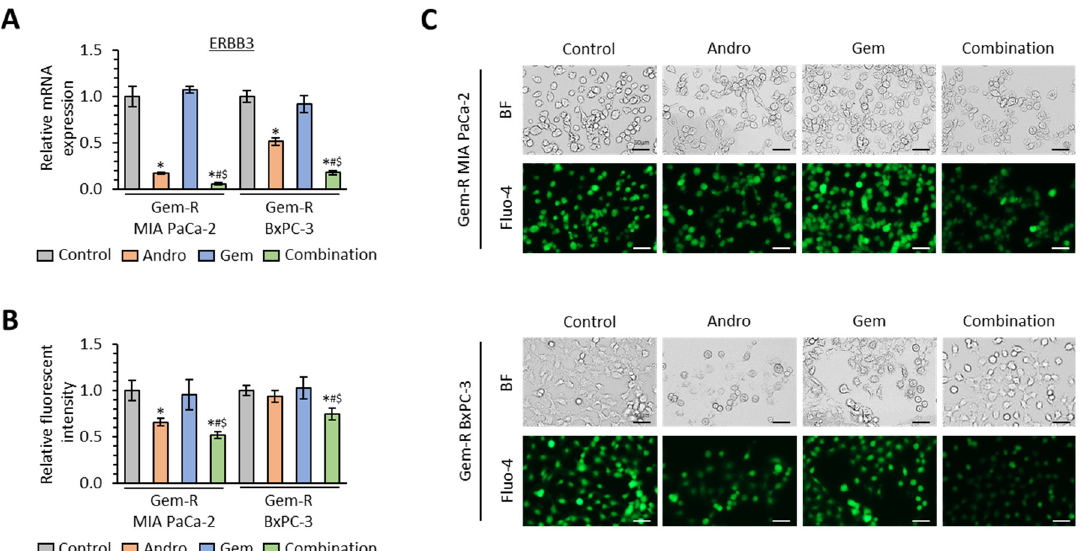
Figure 5. The combination of Andrographis and Gemcitabine down-regulates ERBB3 expression and decreases intracellular calcium concentration in Gemcitabine-resistant PDAC cells. ( A ) qRT-PCR analyses of ERBB3 in Gem-R PDAC cells following treatment with Andro, Gem, and their combination for 48 h. Relative expression was calculated using β -Actin mRNA expression as an internal control. The average (column) ± SD is indicated (* p < 0.05 vs. control, # p < 0.05 vs. Andro, $ p < 0.05 vs. Gem). ( B ) The cellular fluorescence intensity value of Fluo-4 following treatment with Andro, Gem, and their combination in Gem-R PDAC cells. The average (column) ± SD is indicated (* p < 0.05 vs. control, # p < 0.05 vs. Andro, $ p < 0.05 vs. Gem). ( C ) Representative images of Gem-R PDAC cells following treatment with Andro, Gem, and their combination using a bright-field or fluorescent microscope with a 494 nm/506 nm excitation filter under 160 × magnification (scale bar = 50 µ m). PDAC, pancreatic ductal adenocarcinoma; Gem-R, Gemcitabine-resistant; Andro, Andrographis; Gem, Gemcitabine; SD, standard deviation. BF, bright-field.